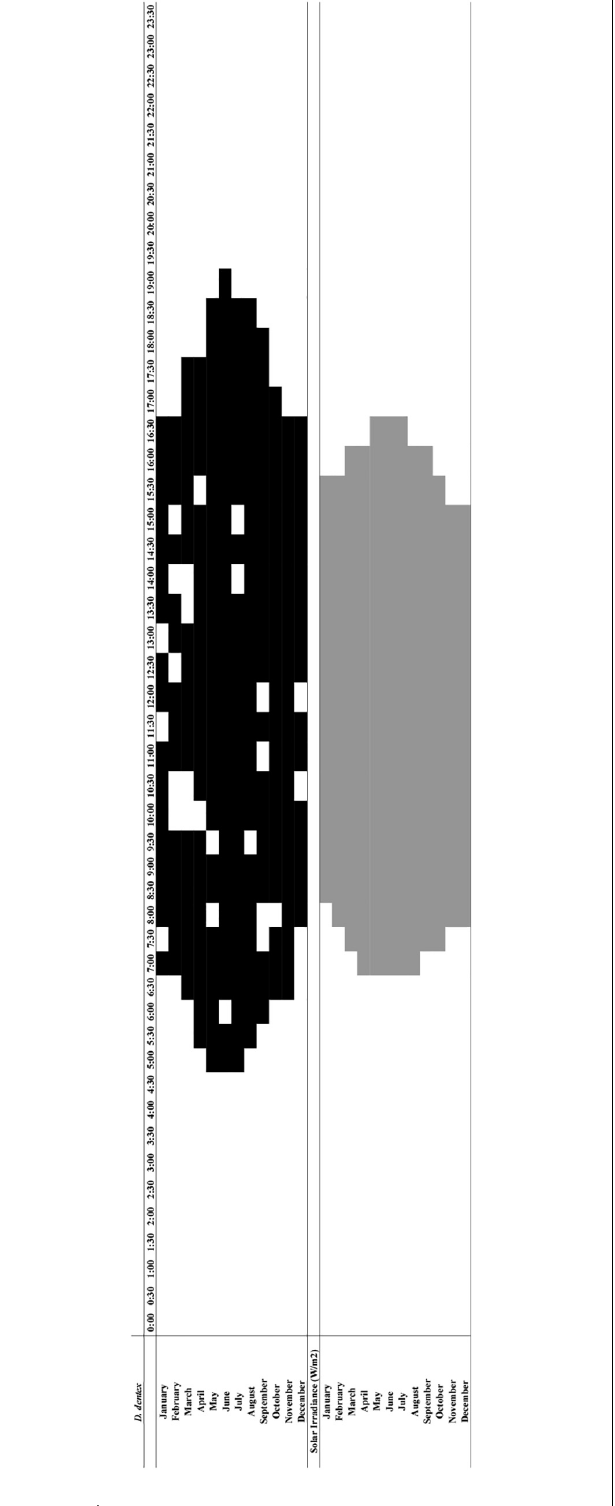
FIGURE 8 | Integrated chart depicting the temporal relationships of D. dentex active phase between months of the year (black), and periods of the diel cycle when the solar irradiance showed significantly increased values along the different months of the year